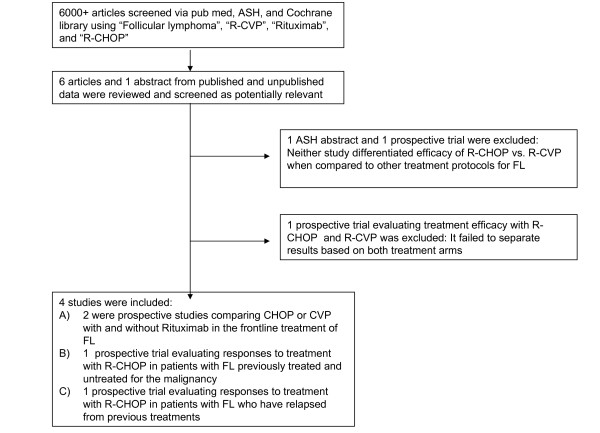
Article review process.